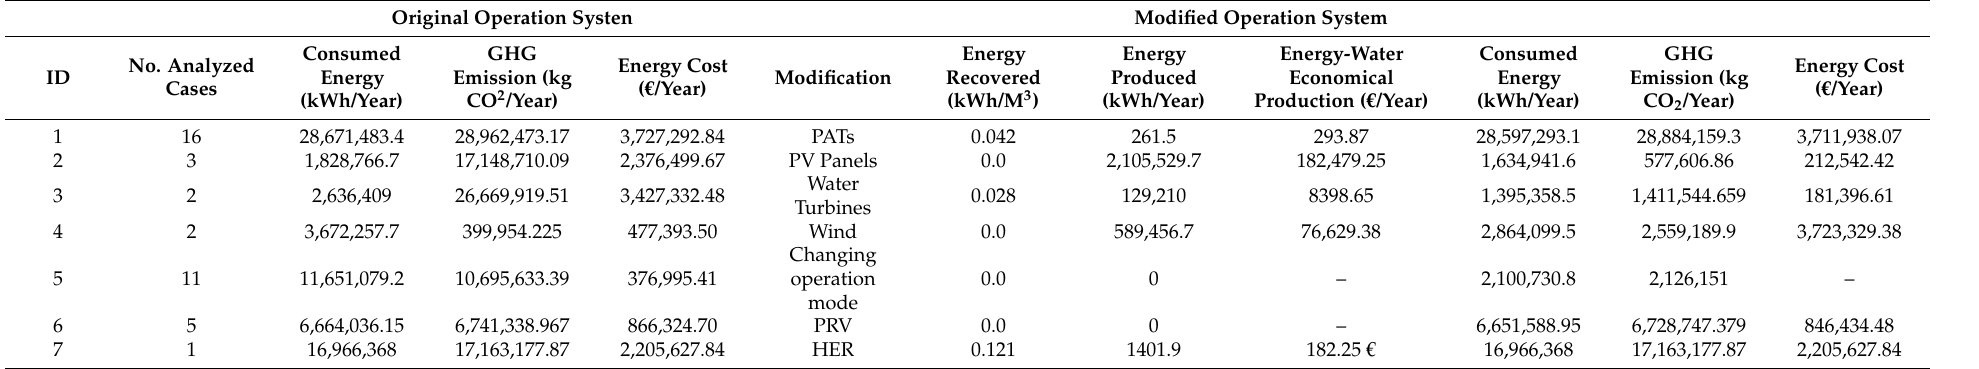
Table 4. Original Operation System and Modified Operation